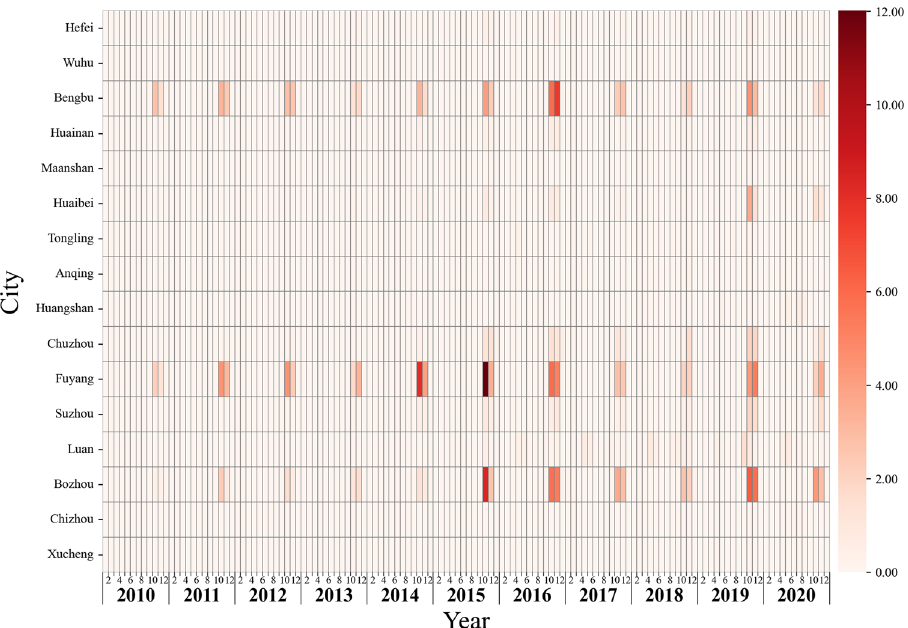
Figure 3. Heat map of monthly incidence of each city in Anhui, 2010–2020. Monthly incidence of all cities were shown in the heat